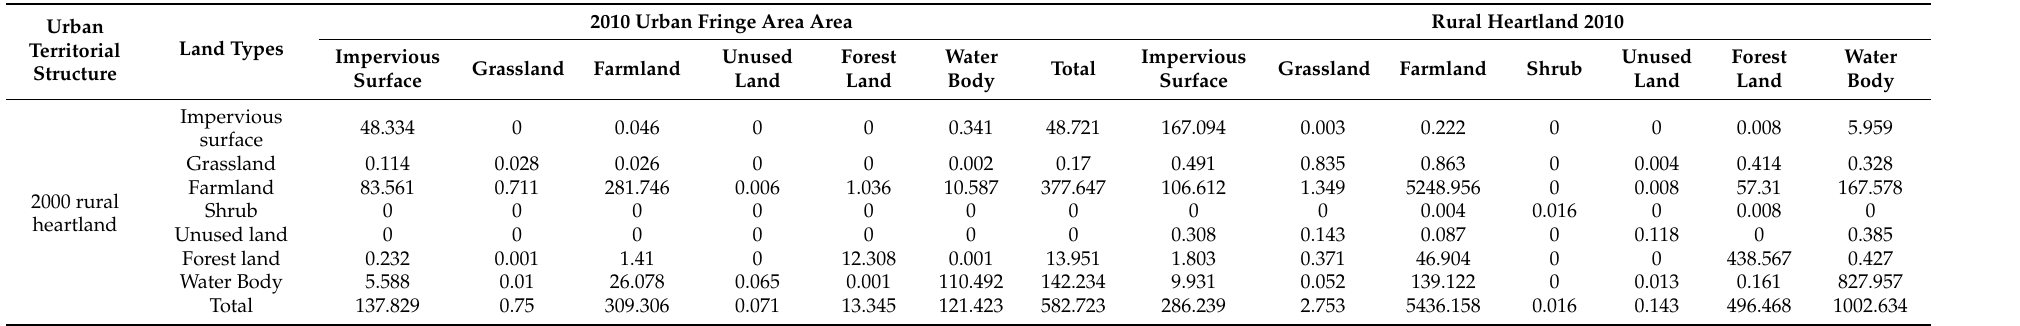
Table A2. Wuhan Land Use Transfer Matrix of rural heartland,